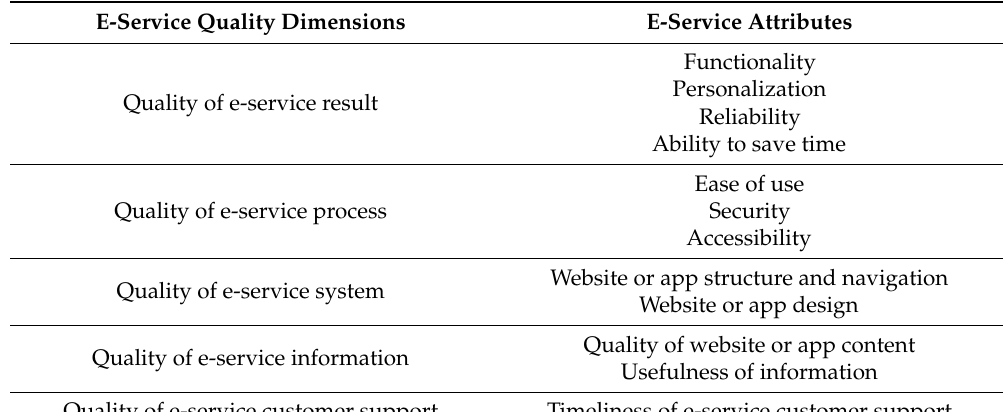
Table 1. E-service quality dimensions and